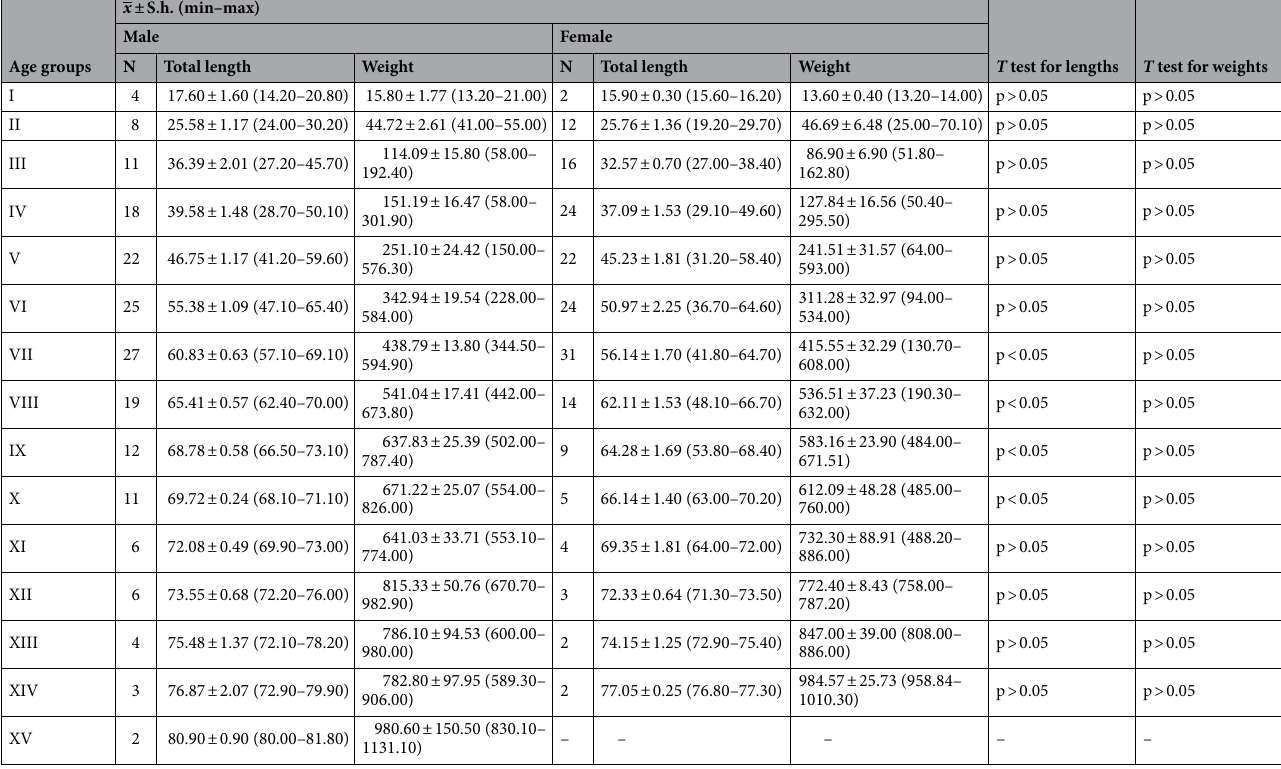
Table 1. Total length (cm) and weight (g) values of M. mastacembelus population inhabiting Keban Dam Lake.